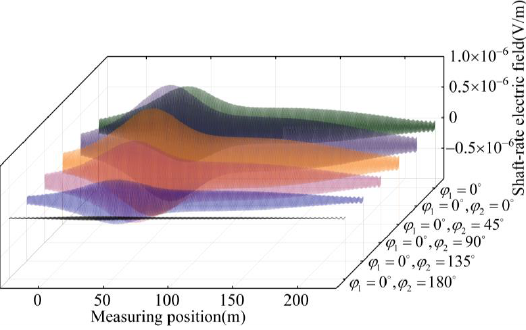
Figure 10. Shaft-rate electric field distribution of a ship. Table 2. Amplitude of a ship’s shaft-rate electric field.